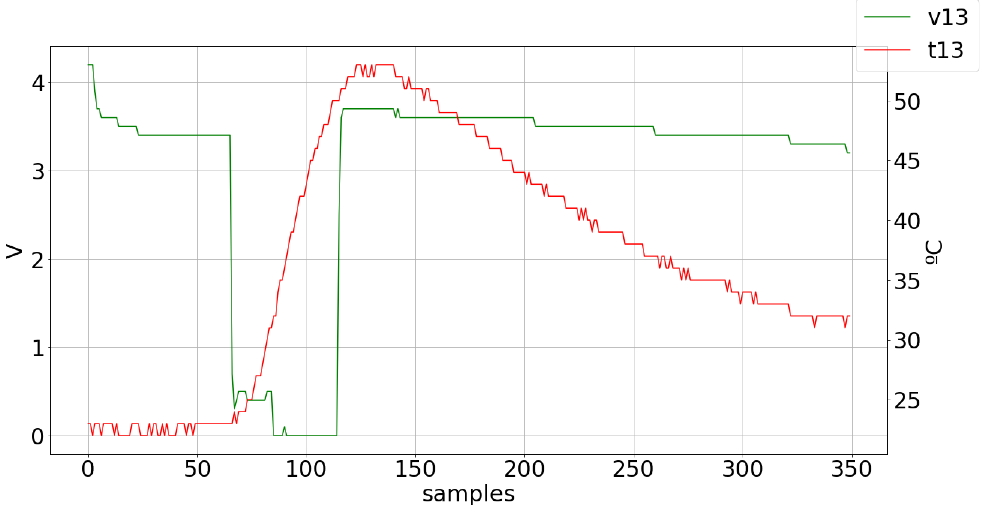
Figure 10. The temperature rises immediately when ESC is observed. The temperature rises immedi- ately after the abuse is applied.